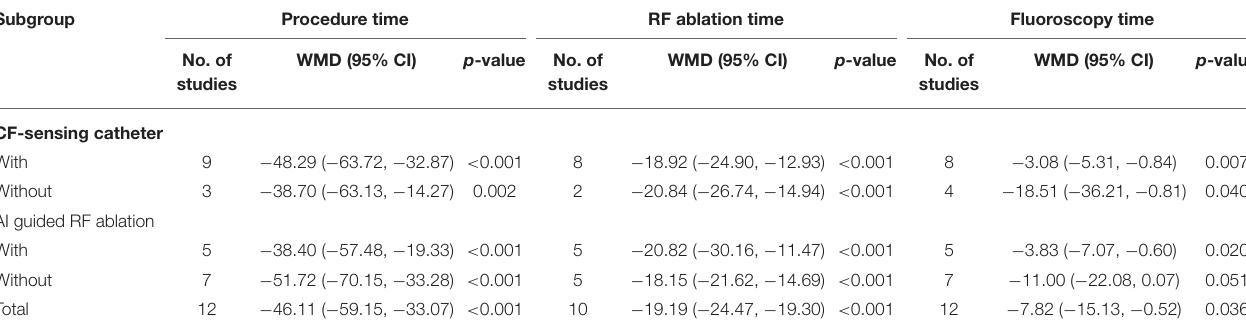
TABLE 5 | Subgroup analysis of procedure time, RF ablation time, and fluoroscopy time.